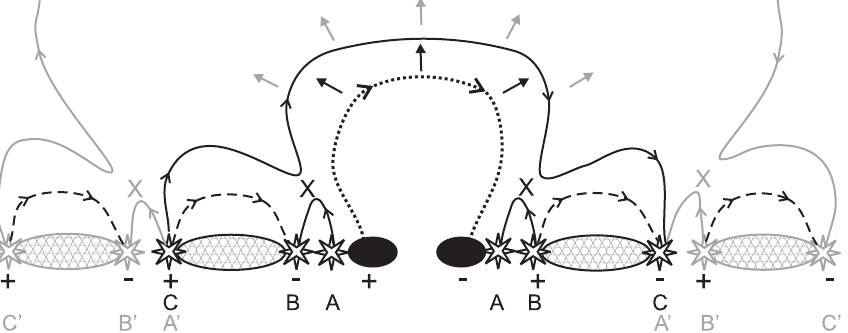
Figure 45: An illustration of the reconnection front model. An expanding CME ( dotted line ) reconnects ( crosses ) with favourably oriented small-scale loops ( dashed lines ) and generates successive brightenings ( A, B, C ) that are observed as stationary and propagating fronts. Image reproduced with permission from Attrill et al. (2007), copyright by